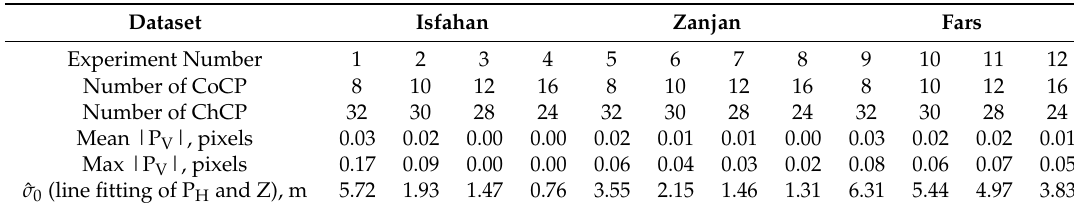
Table 4. Experimental results obtained from the proposed epipolar resampling method.